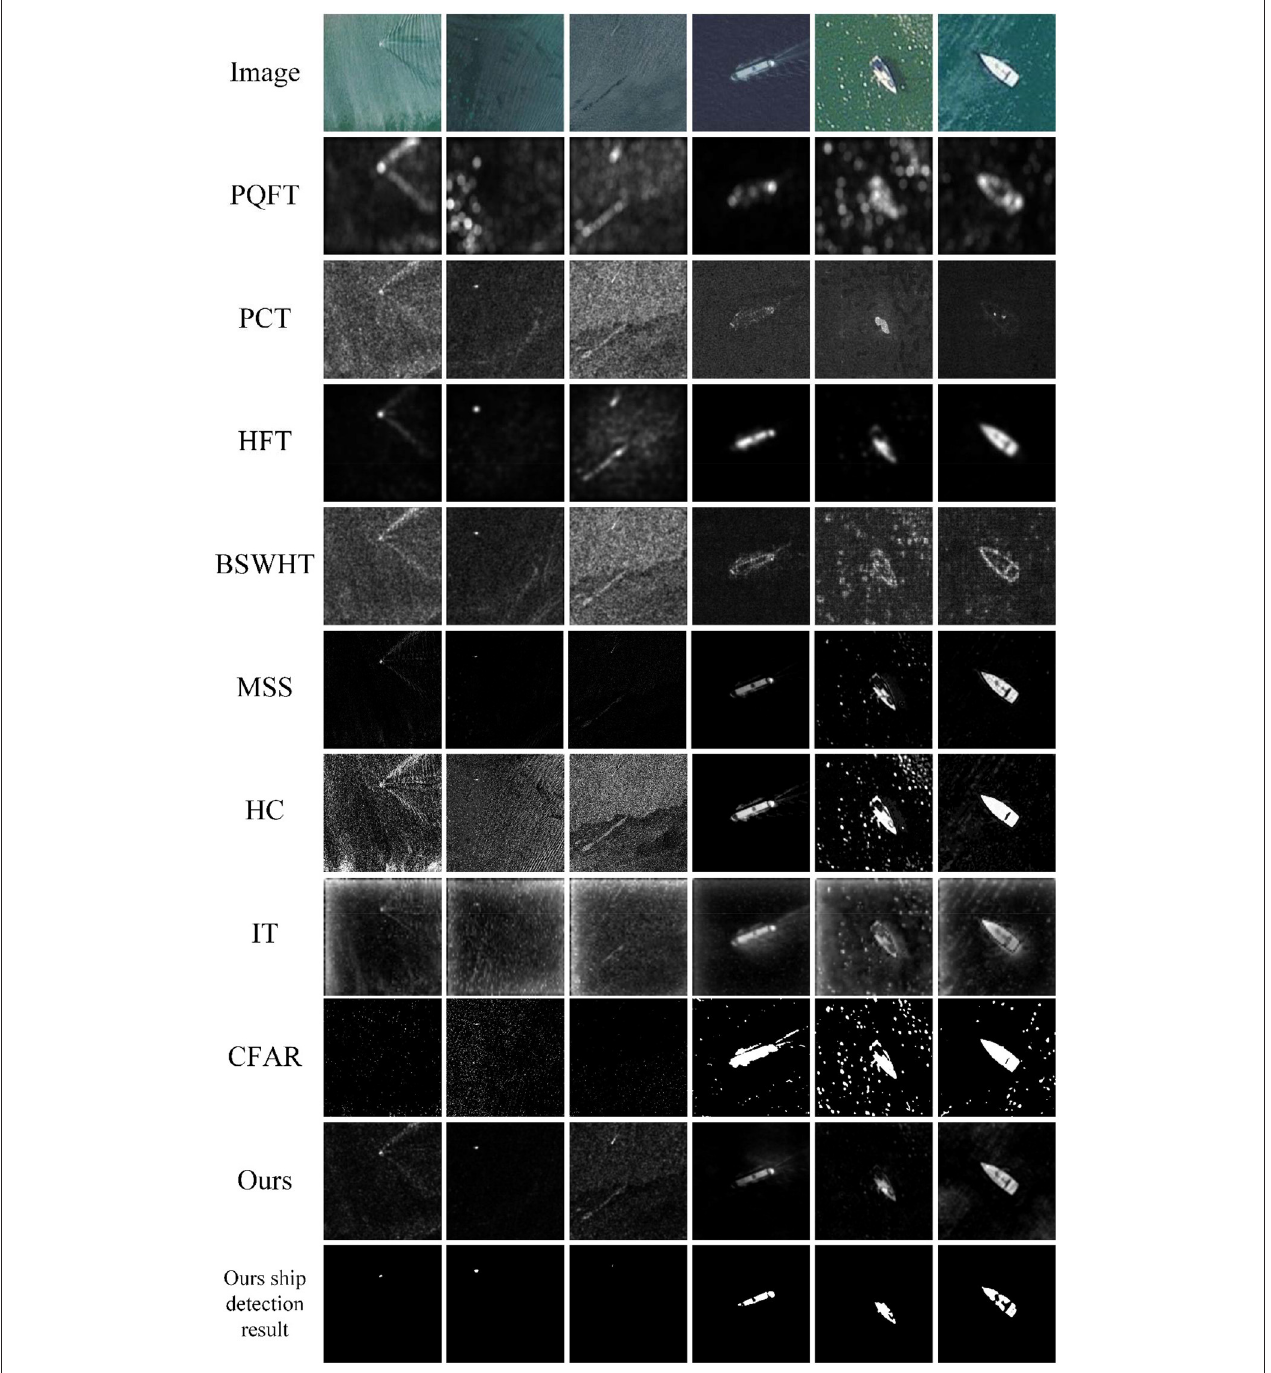
FIGURE 6 | A visual comparison of the saliency maps obtained by all eight approaches, as well as the detection results of CFAR and our method for the MASATI images with a single ship